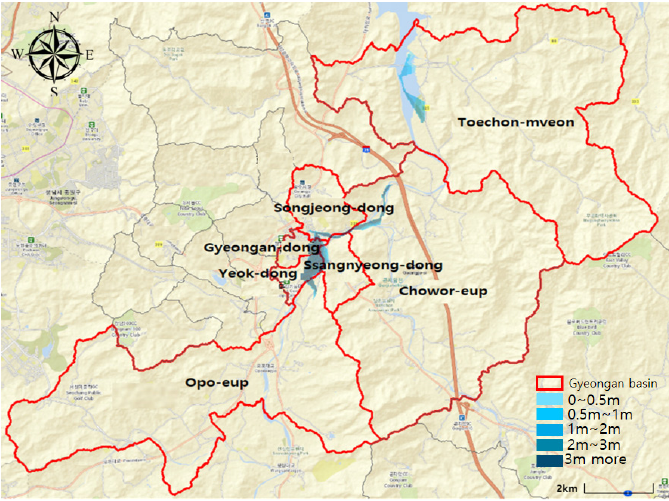
Figure 9. Administrative district map of the Gyeongan stream basin inundated by a mega flood.